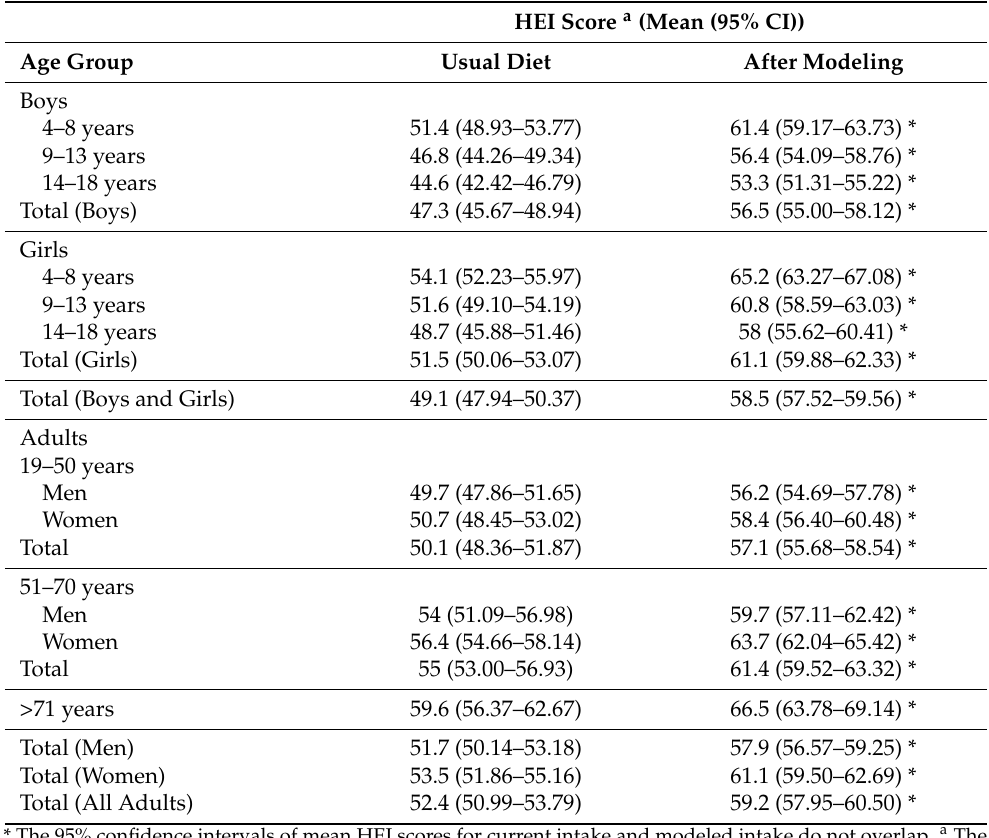
Table 5. Diet quality scores (HEI scores) for usual (current) and modeled intakes (addition of 1 ounce of